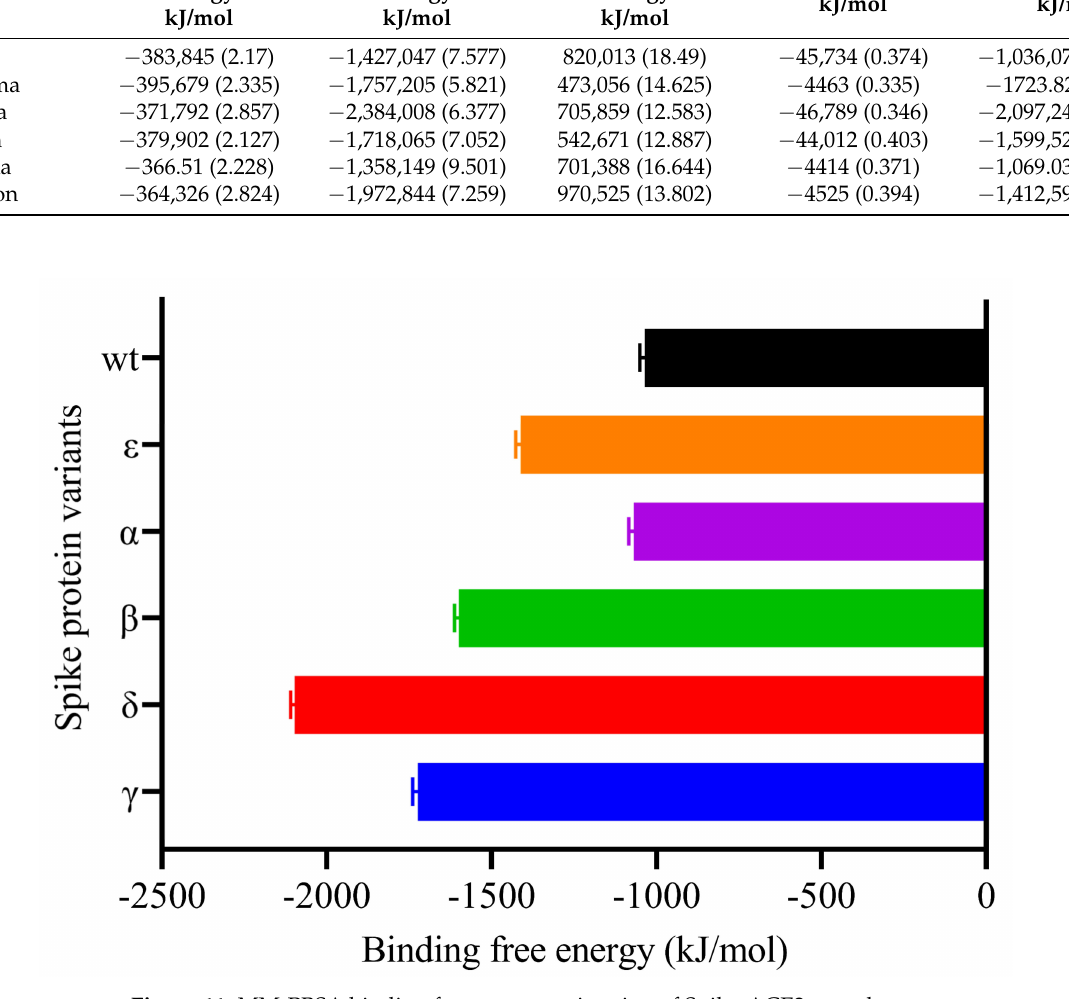
Figure 11. MM-PBSA binding free energy estimation of Spike-ACE2 complexes. As the residual contribution to the binding free energies was examined, no significant changes were observed in the S protein variants, but significant differences were observed in the hACE2 protein (Figure 12). We observed that many residues of the S protein had lower binding free energies than the hACE2 residues, with the most significant change being observed in the interaction of the Delta variant. In particular, we calculated that Asp30, Glu35, and Glu37 in hACE2 were significantly separated from the others as the residues with the lowest binding free energy in the Delta variant. We observed that the His34 residue had high binding free energy in the Alpha, Epsilon, and Beta variants, while the value for Glu75 was significantly lower in the Gamma, Delta, and Beta variants. Chakraborty et al. [60] discovered that His34 of ACE2 had the second highest energetic contribution (4.68 kcal/mol) when compared to Arg403 of RBD via a direct hydrogen